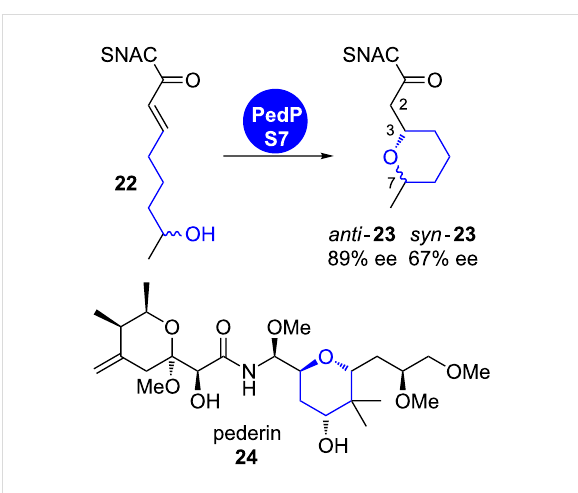
ticin ( 28 ) biosynthetic pathways (Scheme 3 and Scheme 4)